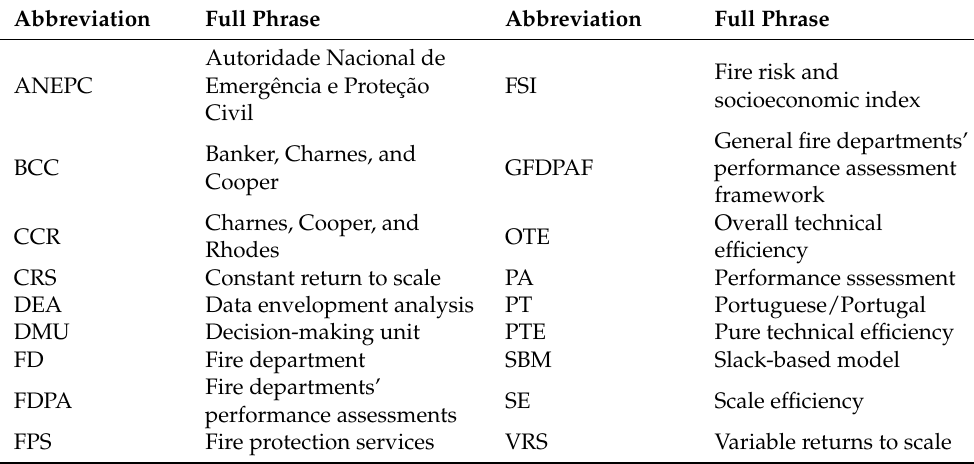
Table 1. List of abbreviations used in the